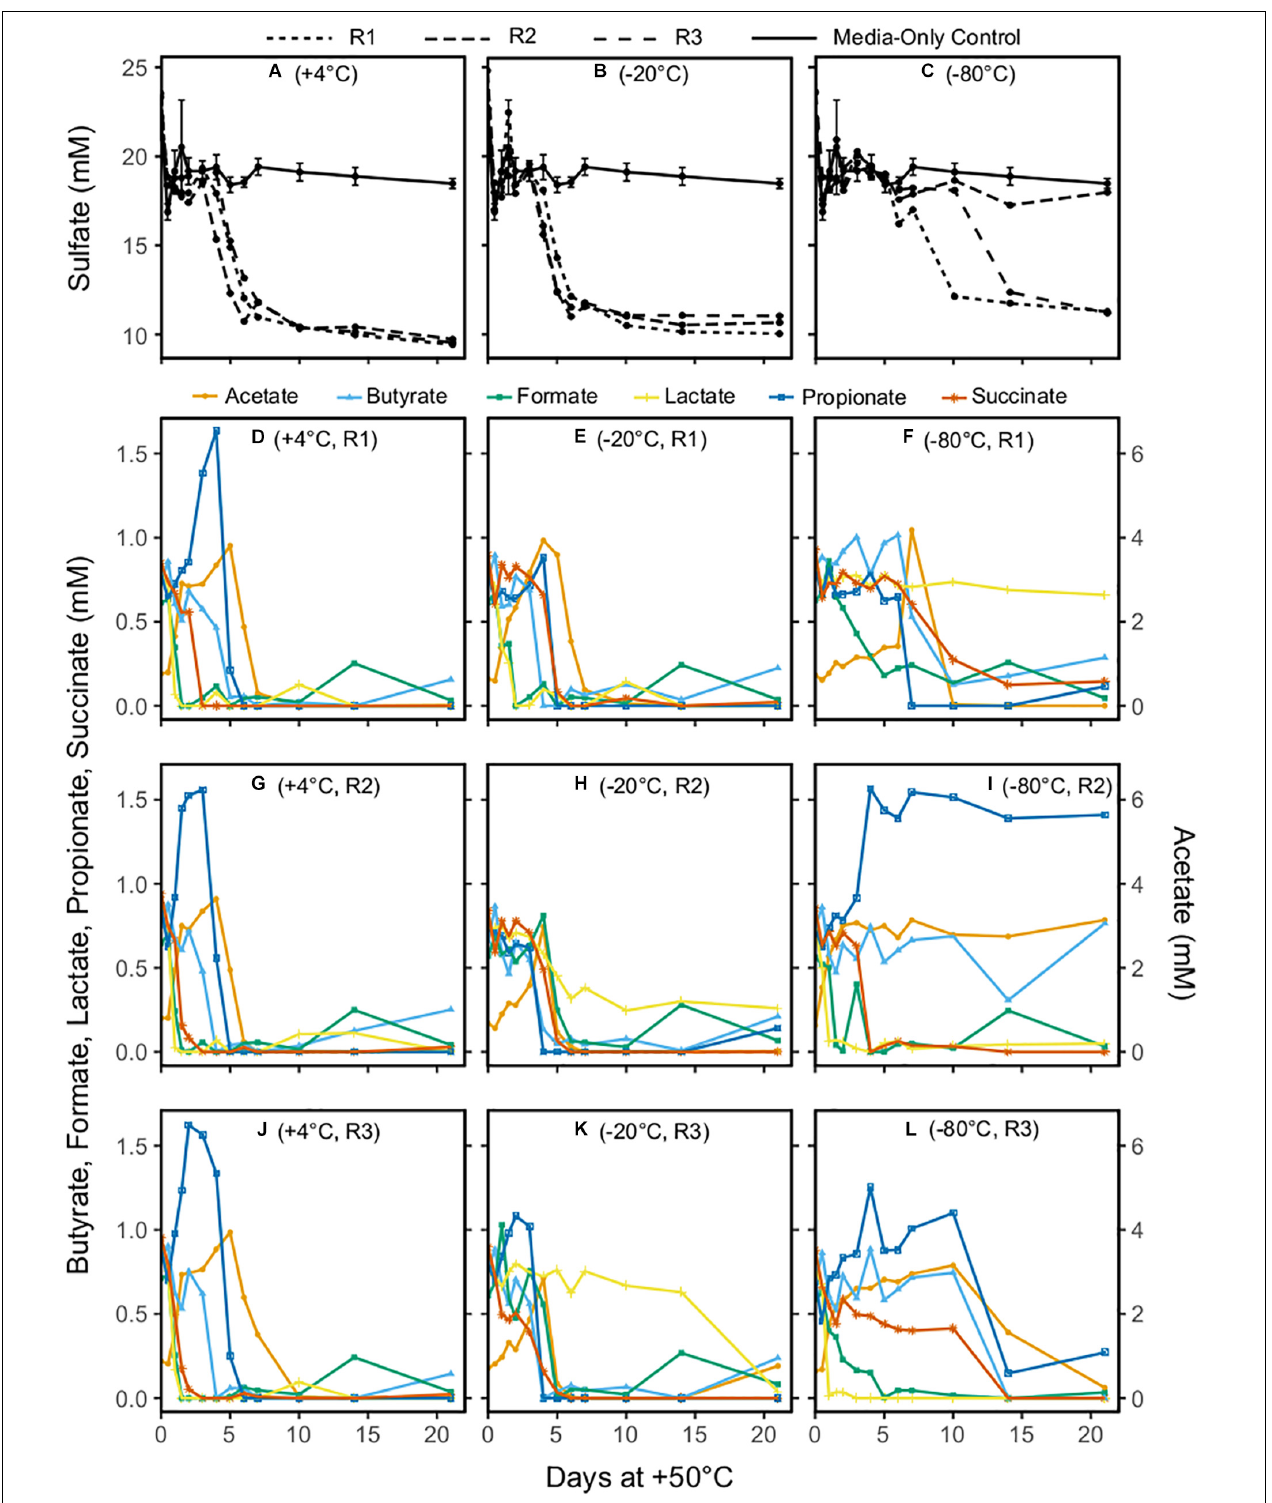
FIGURE 1 | Concentrations of sulfate (A–C) and the organic acids acetate, butyrate, formate, lactate, propionate, and succinate (D–L) in sediment microcosms incubated at +50 ◦ C for 21 days. Acetate is shown on the secondary y -axis owing to its higher concentrations. Replicates are identified as R1, R2, and R3. In panels (A–C) , line types denote the medium-only control (mean of triplicates) and the individual replicates for the –20 and –80 ◦ C pretreatments and the unfrozen control. In panels (D–L) , symbol shapes and colors indicate the six different organic acids measured.